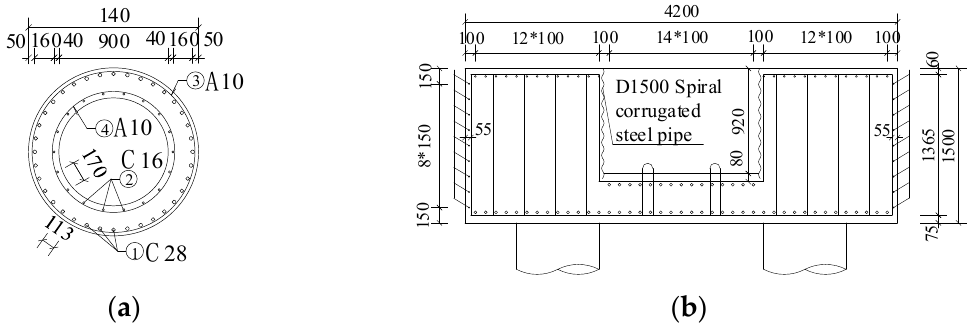
Figure 4. Reinforcement diagram of the full-scale bridge pier. ( a ) Pier section; ( b ) cap reinforcement.